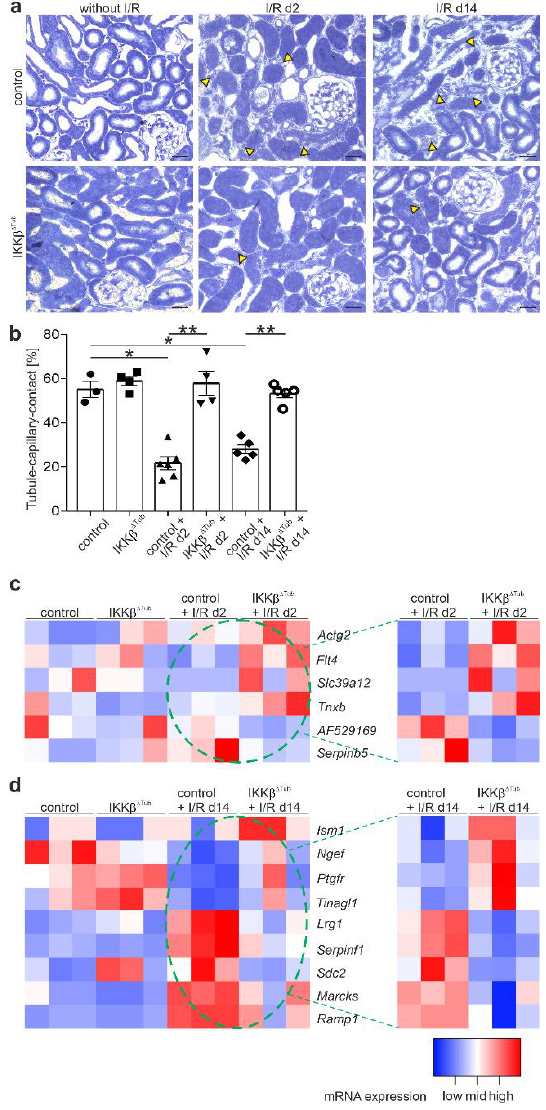
Figure 3. Tubular deletion of IKKβ induces angiogenesis. ( a ) representative images of semi-thin sections from control and IKKβ ∆Tub at baseline, 2 days and 14 days after I/R injury. Scale bar = 50 µm; ( b ) morphometric analysis of tubule – capillary contact length in %. Arithmetic means ± SEM of n = 3 – 6 per group; * p < 0.05, ** p < 0.01 using a Mann – Whitney – U test (if n < 4 Lord test). ( c , d ) Heatmaps of significantly altered mRNA of proteins known to affect angiogenesis at 2 days after I/R injury compared to baseline ( c ) and at 14 days after I/R injury compared to baseline ( d ). Filter criteria were DESeq p -values < 0.05; fold change > 1.5. All heatmaps show samples organized in columns and genes in rows, expression intensities are color-coded. The green stippled circle indicates mRNA of I/R groups used for relative expression in heatmaps by comparing only control with IKKβ ∆Tub at 2 days ( c ) and 14 days ( d ) after I/R injury.